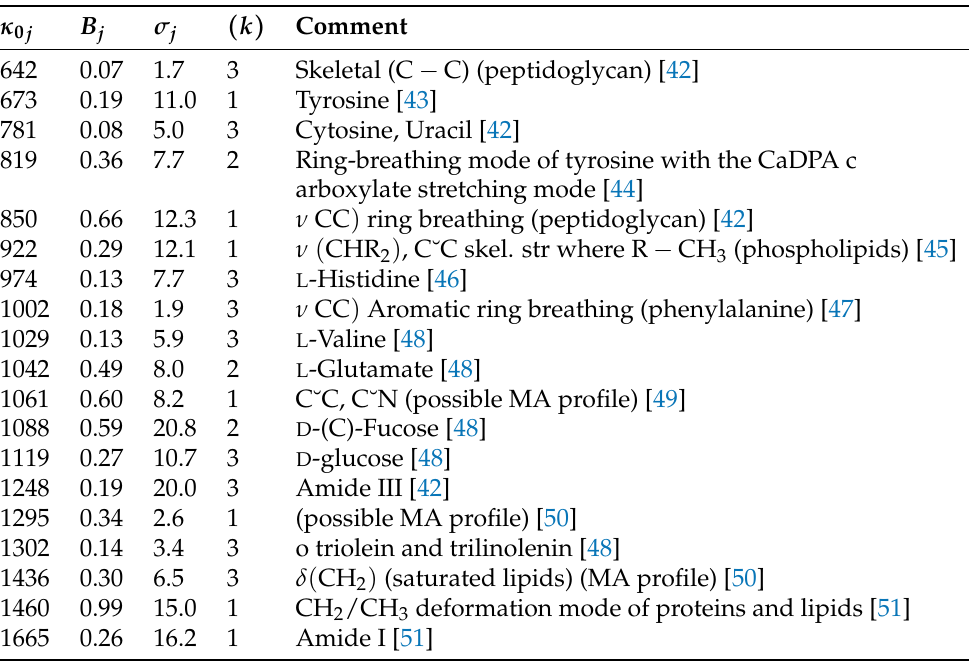
Figure 6. Normalized Raman spectrum of M. tuberculosis pulmonary strain (grin curve) and its decomposition into the series of Gaussian components via the cascade Hilbert-Zero method proposed in this work. Magenta, blue, and red dotted bell-shaped curves show components identified during the first, the second, and the third iterations, respectively. The black dashed curve is the sum of all components resembling main course of principal features revealed. Table 1. The components of the expansion of the Raman spectrum into a series of Gaussian peaks, where κ 0 j is the maximum’s wavenumber (cm − 1 ), B j and σ j are the amplitude and the dispersion (cm − 1 ) of the j -th component. In addition, the numbers ( k ) of the cascade algorithm’s iteration and biochemical comments are provided in the corresponding